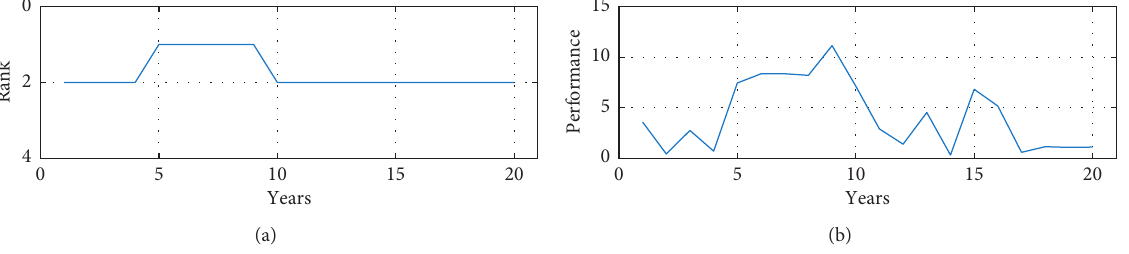
Figure 7: Rank history (a) and performance (b) of agent 108. During the simulation the employee 108 changes his/her